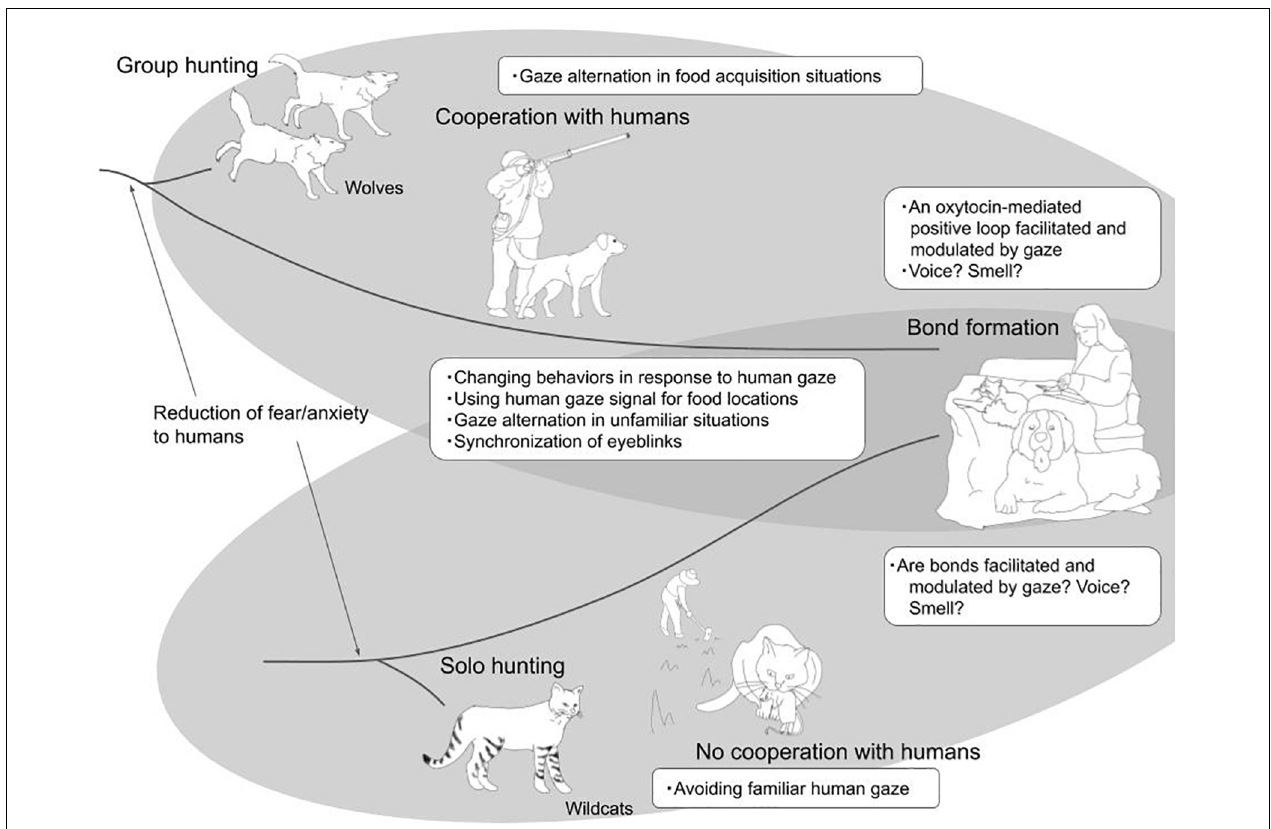
FIGURE 1 | Domestication of dogs and cats and gaze communication with humans. Although dogs and cats have ancestors with a different nature, they have started living with humans, using nonverbal communication, especially gaze. The similar gaze communications observed in both dogs and cats were shown in the overlap of two circles. Using non-verbal communicative signals they can form bonds with